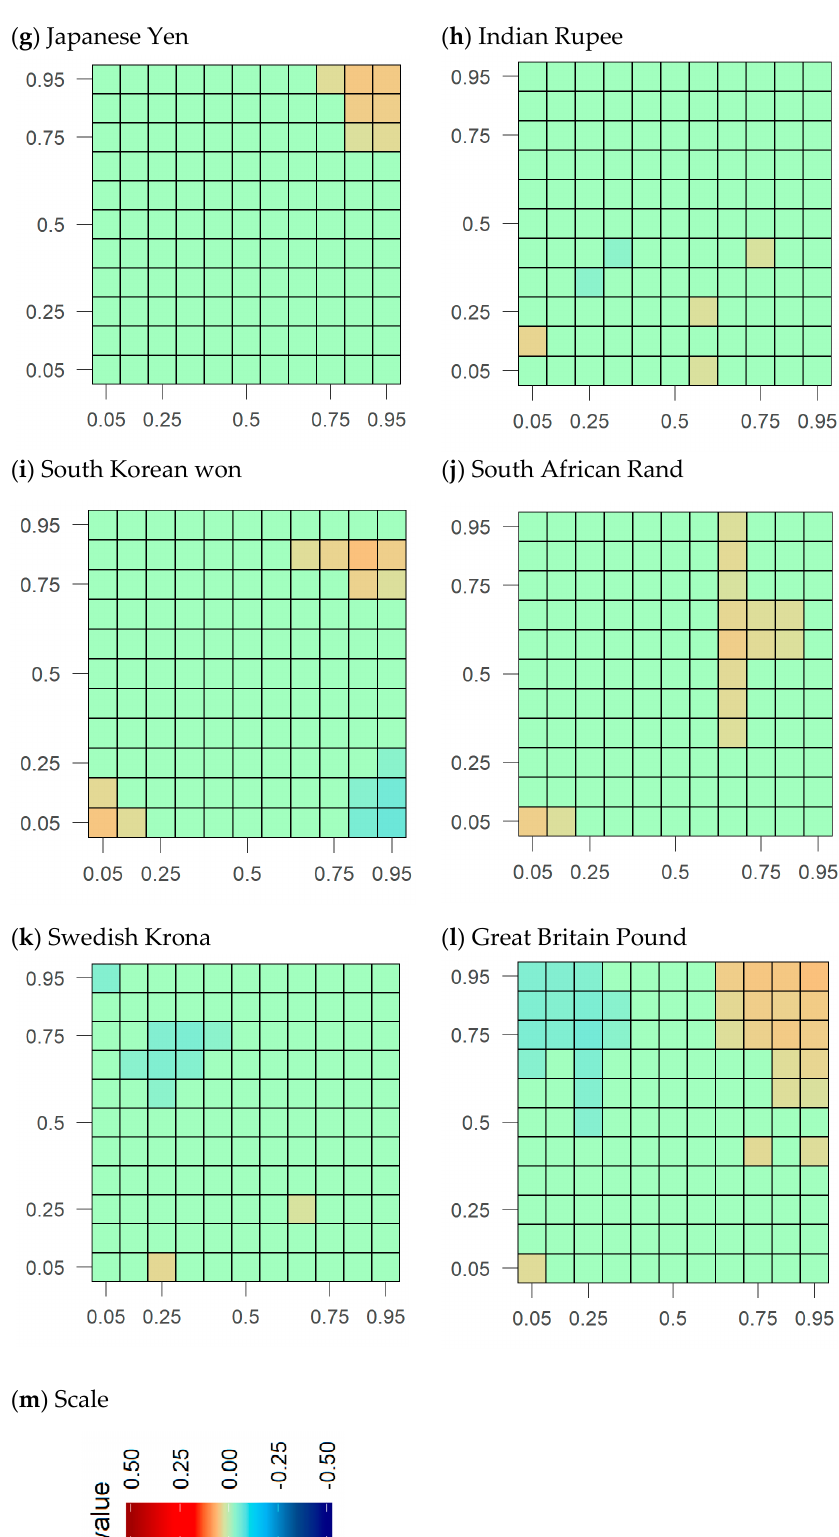
Figure 2. Cross-quantilogram heatmaps between Forex and WTI crude oil. The CQ estimations are shown in the form of heat maps. Insignificant values are set to zero. Statistically significant Box–Ljung statistics are presented by colored rectangles. Forex return quantiles are displayed on the horizontal axis and vertical axis contains the WTI crude oil return quantile.